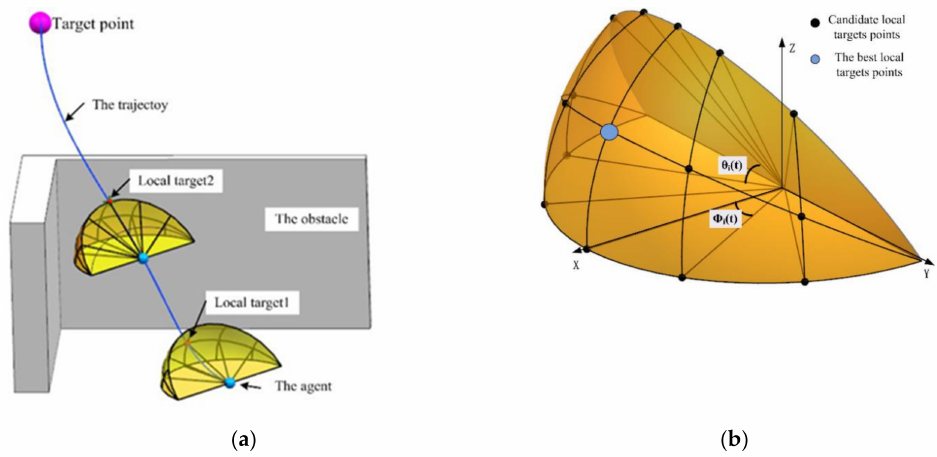
Figure 4. ( a ) Local goals in trajectory planning and ( b ) the position of the local